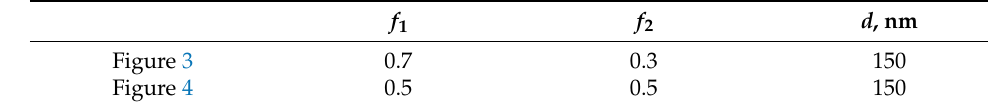
Table 1. The geometrical parameters which correspond to Figures 3 and 4.